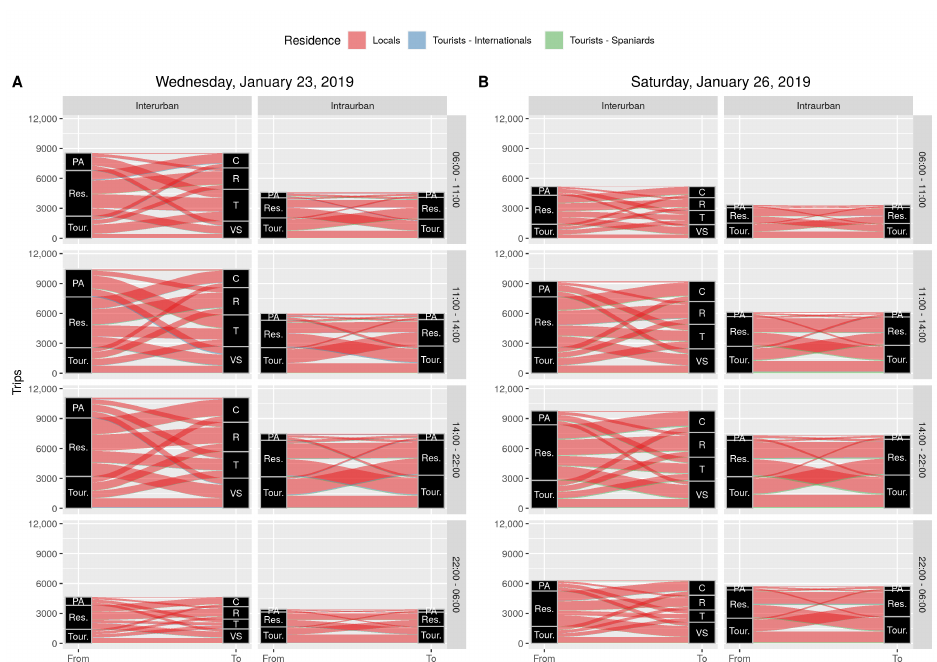
Figure 9. Alluvial diagrams showing the winter mobility of local residents, national tourists and international tourists in Salou. Intra-urban mobility shows the movements between the different areas of Salou—PortAventura (PA), Residential (Res), Tourist (Tour), while inter-urban mobility shows the movements from these areas and to the most important municipalities in the area—Cambrils (C), Reus (R), Tarragona (T), and Vila-seca